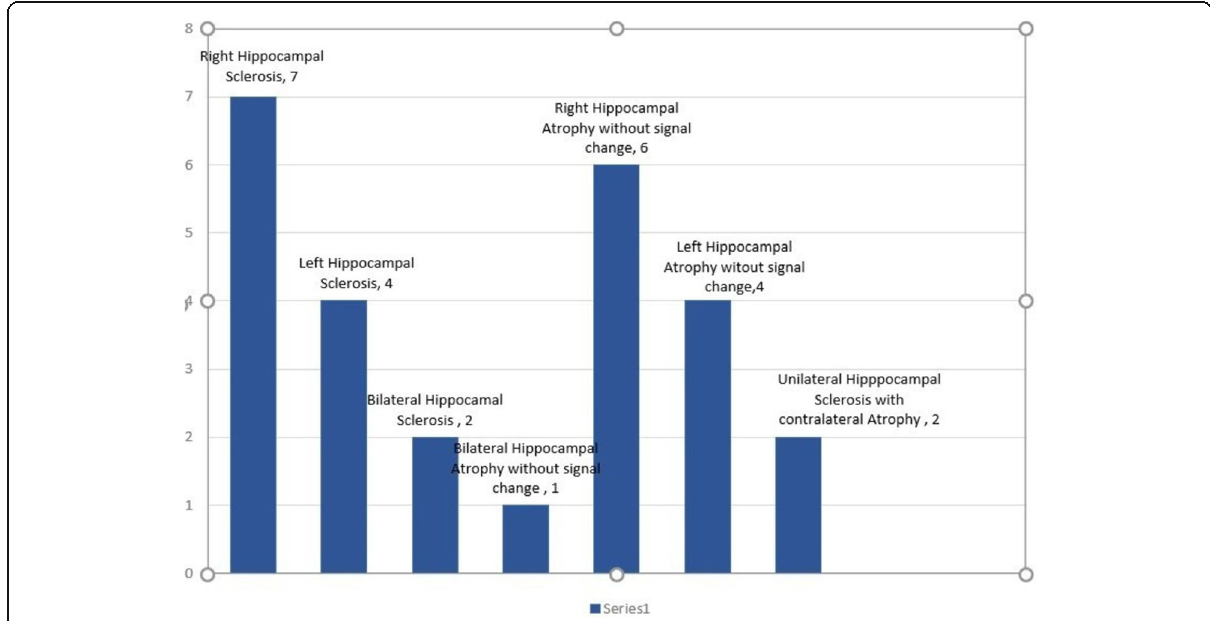
Fig. 4 Distribution of hippocampal atrophy with T2 hyperintensity in patients with focal onset seizure with impaired